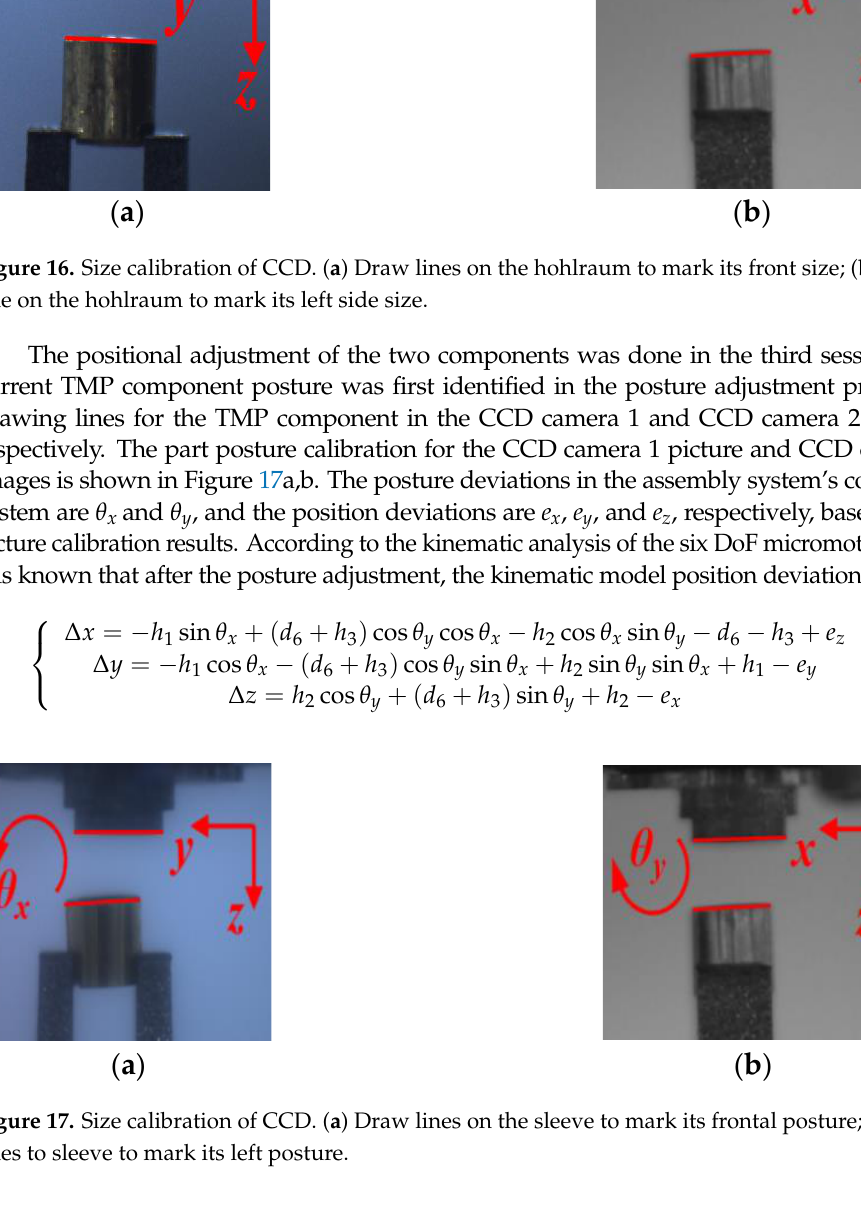
Figure 17. Size calibration of CCD. ( a ) Draw lines on the sleeve to mark its frontal posture; ( b ) Draw lines to sleeve to mark its left posture.